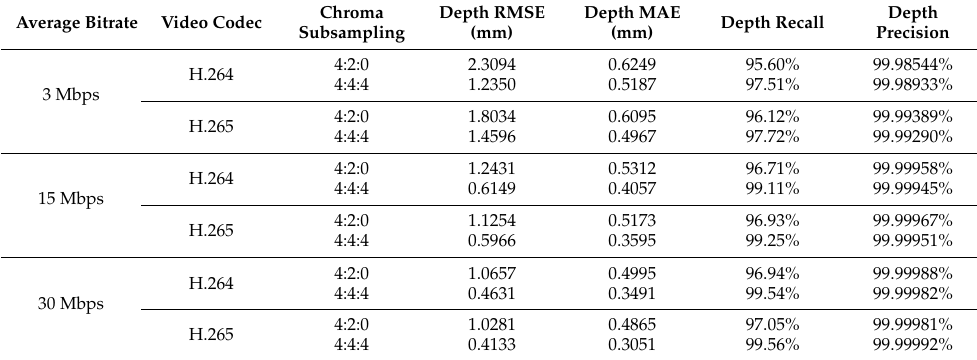
Table 1. Quantitative depth reconstruction results at select bitrate targets. All quantitative measures are taken as aggregates over the entire 582-frame reference video encodings. All MWD encodings used n stairs = 6 and other settings were as described in the first paragraph of Section